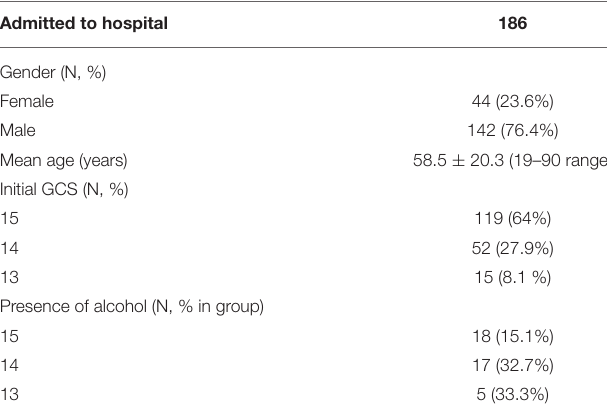
TABLE 1 | Characteristics of the study